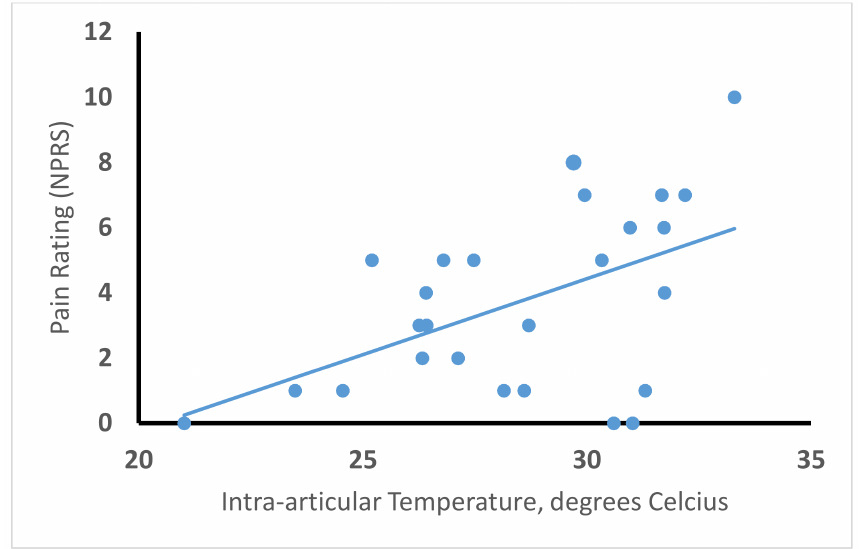
Figure 3. Procedural pain was significantly and positively, associated with intra-articular (IA) temperature. In each of 13 individuals with knee OA, different techniques for cooling the left and right knee joints were used, resulting in varying IA temperatures (measured by an IA temperature probe). IA lidocaine, followed by capsaicin (1mg), was administered and procedural pain (on a Numerical Pain Rating Scale, NPRS) and IA temperature were measured at intervals following the injections. The plot of NPRS versus IA temperature demonstrated a positive (r = 0.51) and significant (P = 0.008) correlation. These data support the use of joint cooling as a means to decrease procedural pain associated with IA capsaicin injection. Number of subjects = 13; both knees represented for each